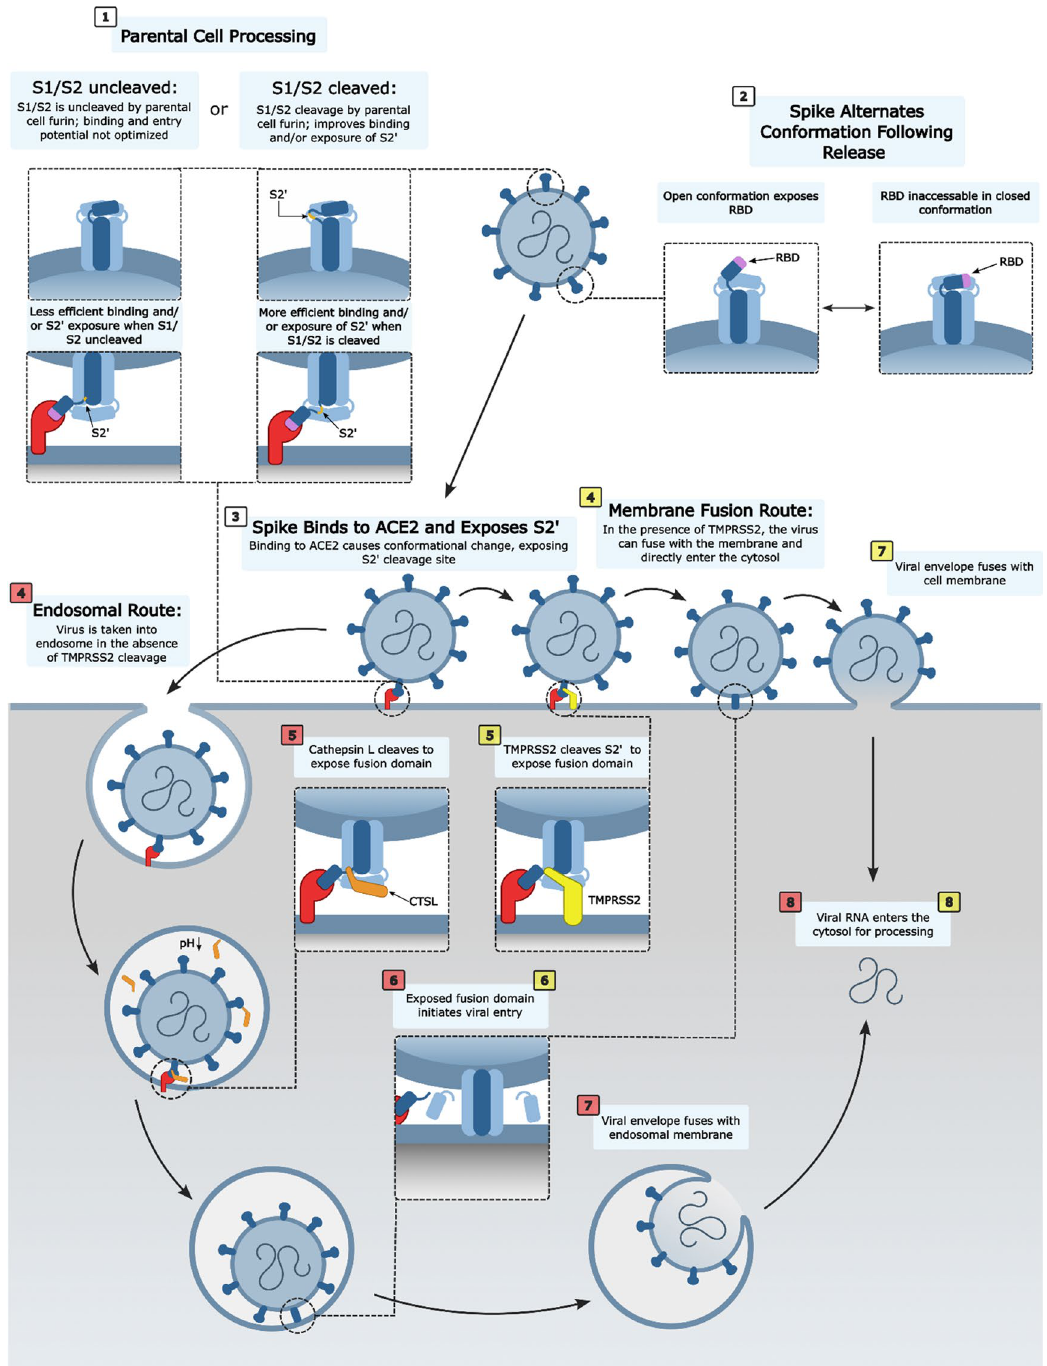
Fig. 3 Attachment and entry model of SARS‑CoV‑2. When SARS‑CoV‑2 is released by the parental cell, some S is cleaved by host furin. Cleavage by furin facilitates faster binding to the functional receptor ACE2. The binding of ACE2 to S induces a conformational change which exposes the S2’ cleavage site. The presence or absence of TMPRSS2 dictates whether the virus enters through a fast membrane fusion or a slow endosomal route. In the absence of TMPRSS2, the virus is taken into an endosome where the pH will drop, activating cathepsin L. Cathepsin L cleaves S to initiate fusion to the endosomal membrane before release of viral RNA into the cytosol. In the presence of TMPRSS2, the S2’ site is cleaved and the virus can fuse directly to the cell membrane, allowing for a more rapid entry of the viral RNA into the